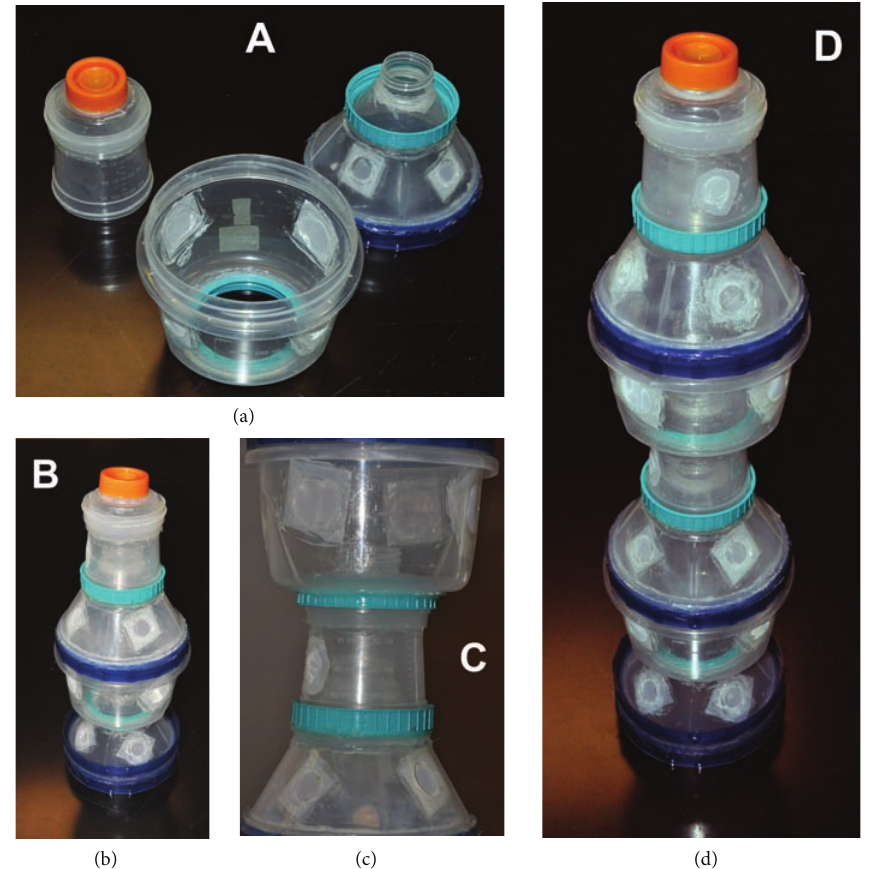
Figure 3: Cage system assembly. (a) Cage unit components, (b) cage unit assembled, (c) connection cup with second cage unit fitted, and (d) cage series assembly of two cage